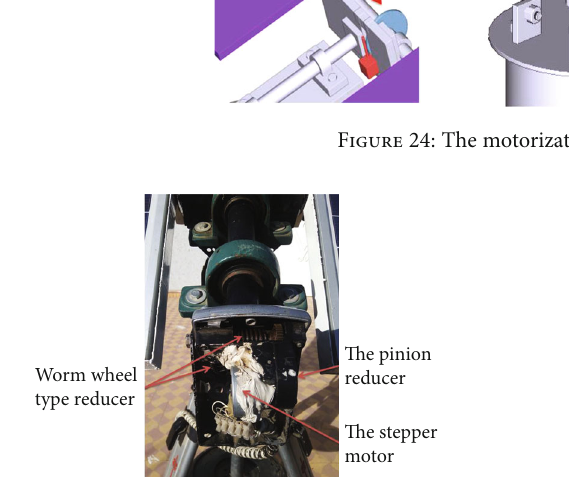
Figure 25: The type reducer “ DiseqC motor ” with a stepper motor.